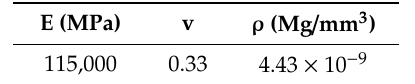
Table 3. Elastic properties of Ti-6Al-4V used in this paper.